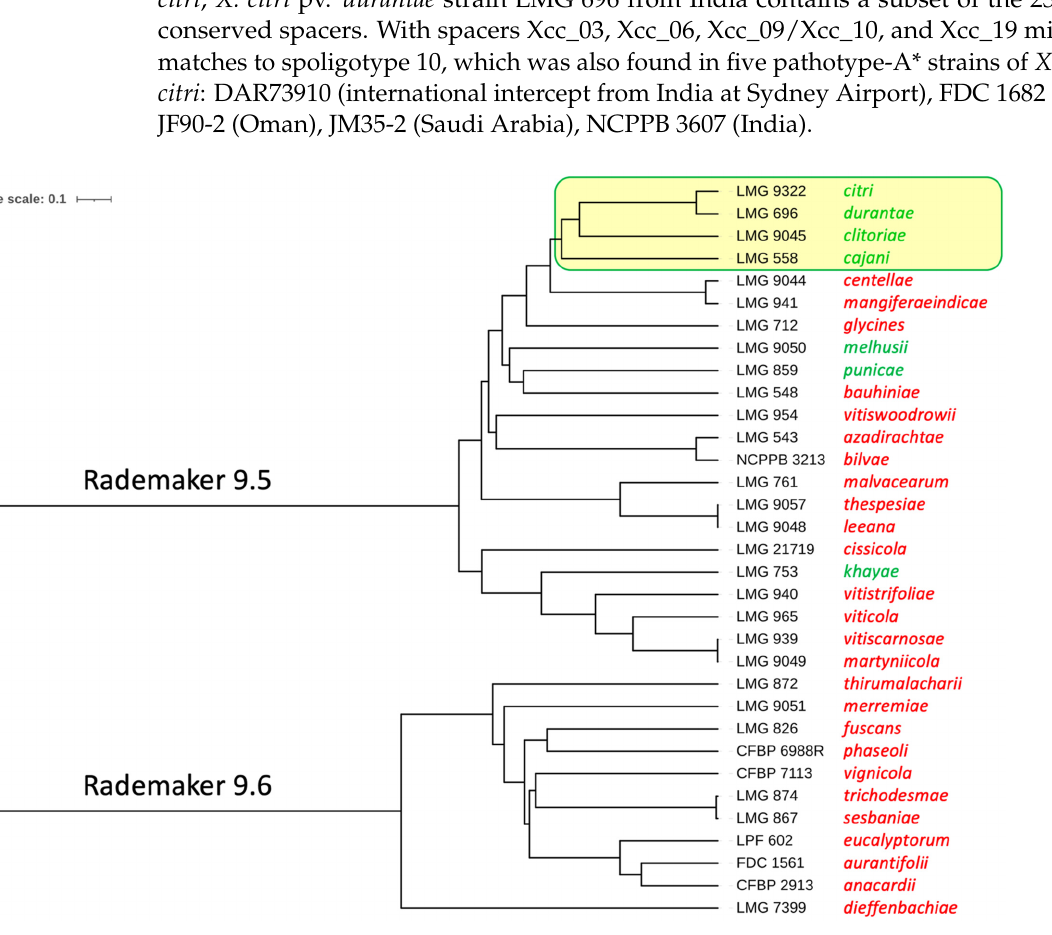
Figure 4. Phylogenetic tree of representative strains from 33 X. citri pathovars. Genome-wide pairwise average nucleotide identities were calculated, and their phylogenetic analysis was performed on the enve-omics platform [21]. Complete (maximum) linkage clustering was used to build the phylogenetic tree [31]. The interactive Tree Of Life (iTOL) suite was used for better visualisation of the tree [32]. 22 pathovars cluster within the Rademaker 9.5 group and 11 pathovars cluster within the Rademaker 9.6 group [18]. Strain names are shown to the left of the tree, followed by the pathovar name. Pathovars with CRISPR arrays are shown in green and those without CRISPR arrays in red. Strain LMG 558 ( X. citri pv. cajani ) contains 26 spacers, twelve of which are shared with X. citri pv. citri , whereas the other spacers have not been identified before. Notably, four of the novel spacers are shared with strain LMG 9045 ( X. citri pv. clitoriae ). In addition, this strain contains six of the 23 canonical spacers of X. citri pv. citri . Strains of the other three pathovars have also a few spacers in common with X. citri pv. citri , albeit at a smaller number, and they share spacers with each other and with pv. clitoriae . Our dataset in- cludes ten strains of X. citri pv. punicae , for which we describe three different spoligotypes. In total, the set of strains beyond pathovar citri contains 103 hitherto undescribed spacers; 62% of them do not have significant hits at NCBI GenBank’s non-redundant da- tabase. Among those with homologs, 30% matched to bacteriophage sequences and 75% matched to sequences in the genomes of xanthomonads. Since 35 of the novel spacers are at positions between one of the 23 canonical X. citri pv. citri spacers and the terminator, they must have been there before the divergence of the different pathovars of X. citri . Hence, the common ancestor of these pathovars contained a CRISPR array significantly larger than that of the founder of the pathovar citri lineage.